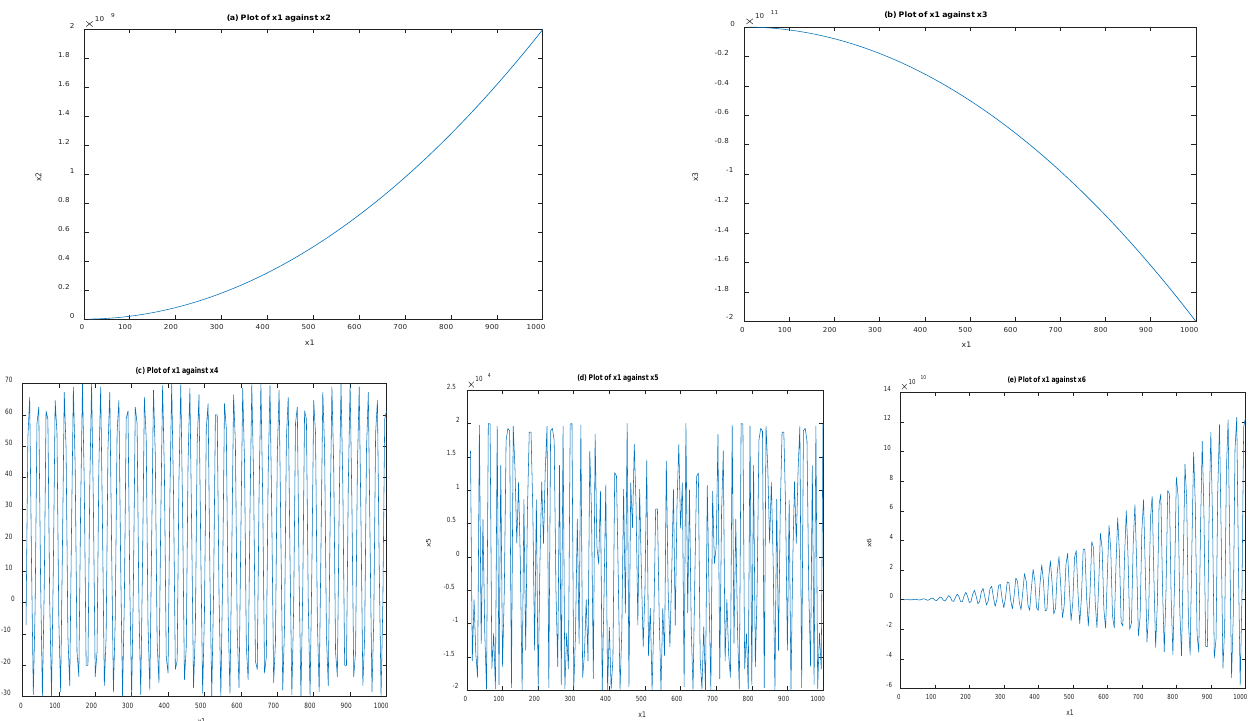
Figure 2. Simulation of the CB model of SoTE for x 1 = 1:0.5:100. ( a )input quadratic function, ( b ) input quadratic function, ( c ) resultant polynomial function, ( d ) induced interference ( e ) output wave function.